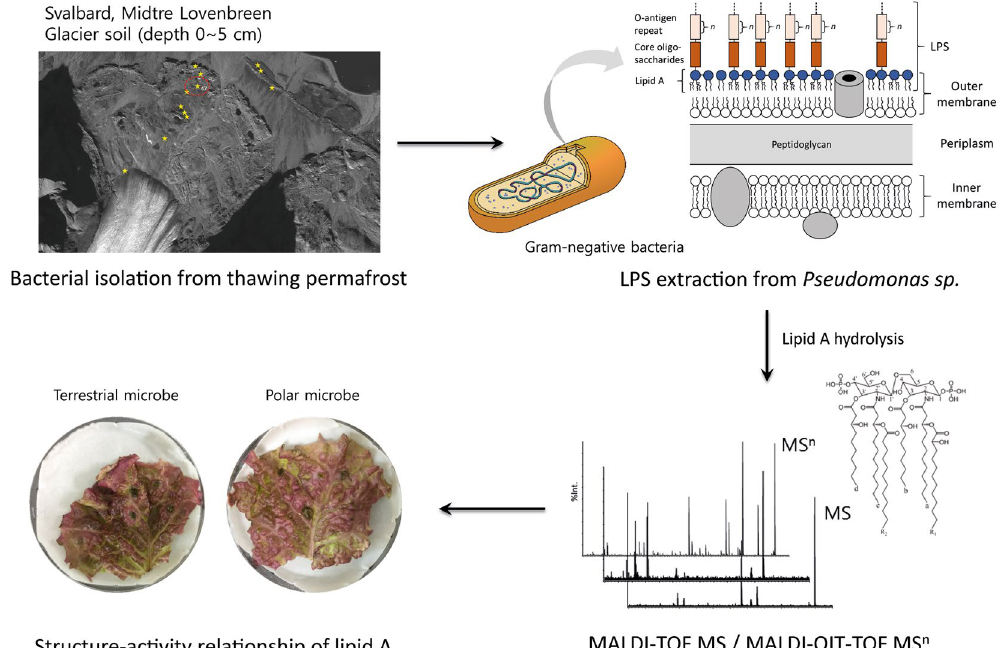
Figure 1. Overall workflow of the characterization of the lipid A molecule from polar Gram-negative bacteria by MALDI-based mass spectrometric approaches and the determination of pathogenical activity via structure- activity